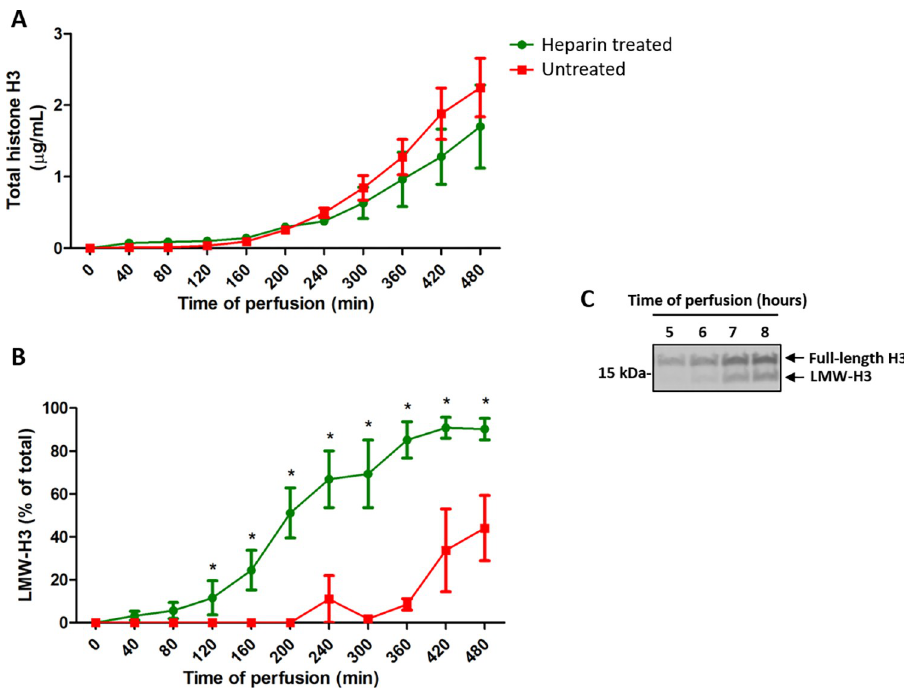
Fig 6. Time-dependent release of histone H3 in heparin treated and untreated kidneys with warm ischemic injury. Extracellular histone H3 was determined in kidneys with or without circulating nonanticoagulant heparin. Kidneys treated with heparin showed a similar release in total histone H3 (A) but a more rapid and pronounced increase in levels of a lower molecular weight histone H3 (LMW-H3) variant (B) compared to untreated counter kidneys. (C) A representative Western blot image of full-length histone H3 (17 kDa apparent MW) and LMW-H3 (15 kDa apparent MW) in perfusate of untreated SNMP kidney at t = 5, 6, 7 and 8 hours of perfusion. � Indicates significant differences between groups (p <